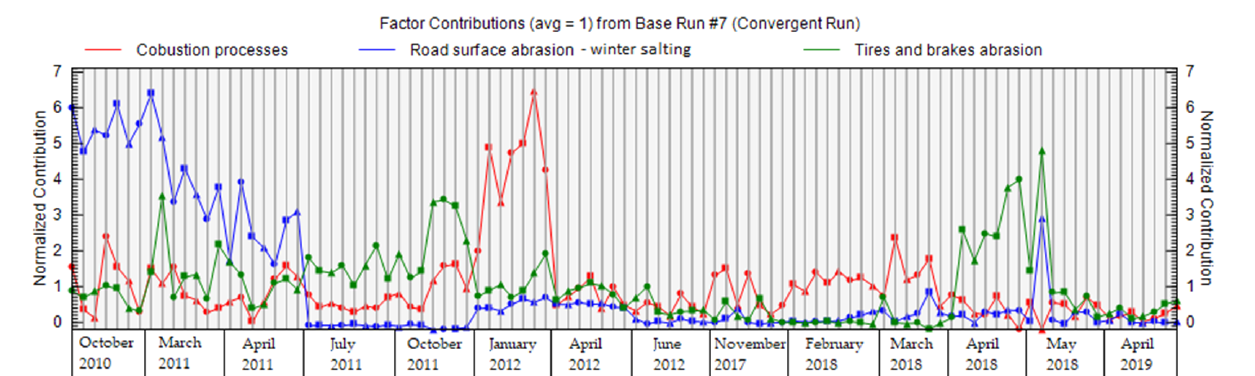
1 measurements in the city of